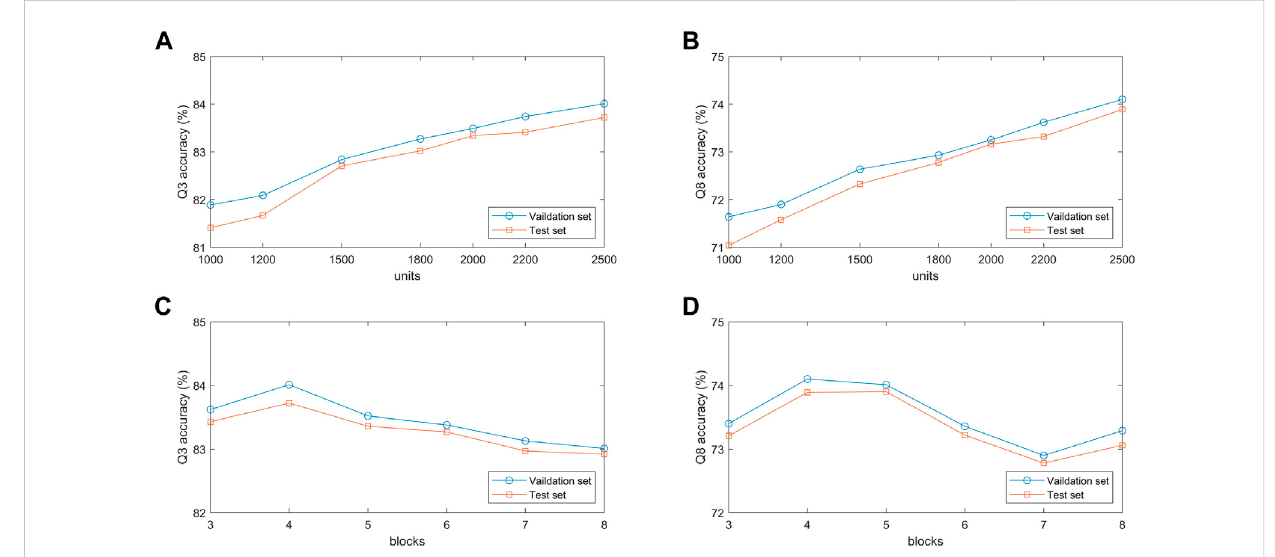
FIGURE 7 (A,B) Q3andQ8accuracyoftheproposedmodelunderdifferentnumberofunits. (C,D) Q3andQ8accuracyoftheproposedmodelunderdifferent number of blocks.